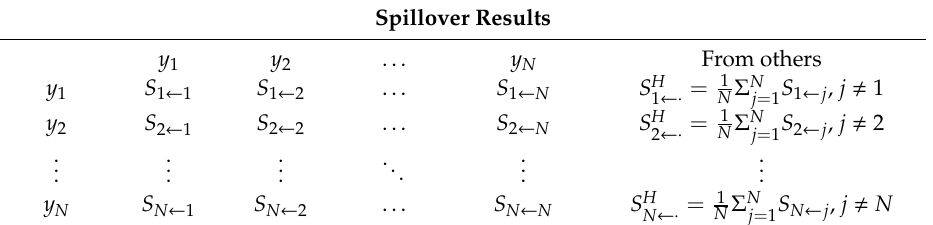
Table 1. The spillover table of the Diebold–Yilmaz approach